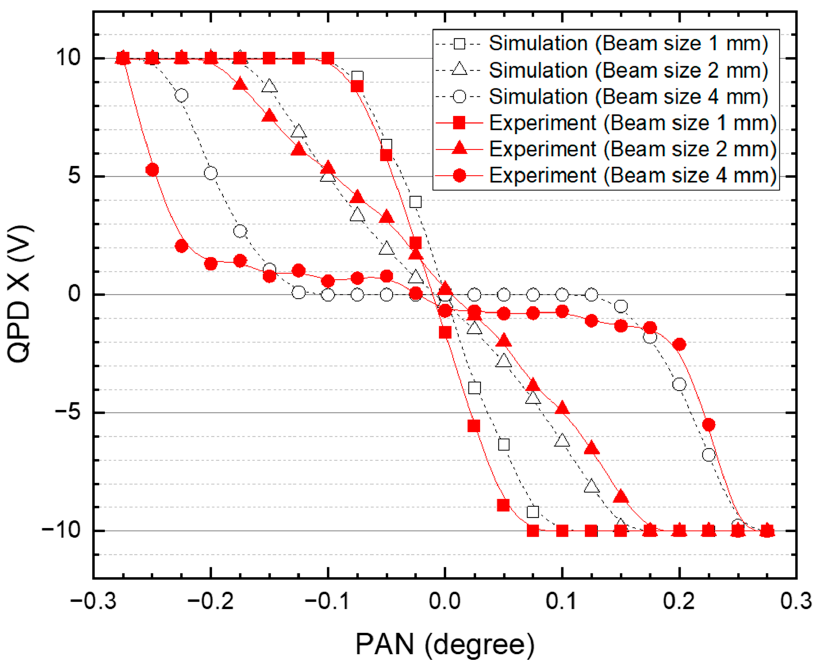
Figure 5. Result of X value of QPD based on incident beam size on QPD with respect to the change of pan angle of PTU. The dotted and solid line represent the simulation and experimental results, respectively.